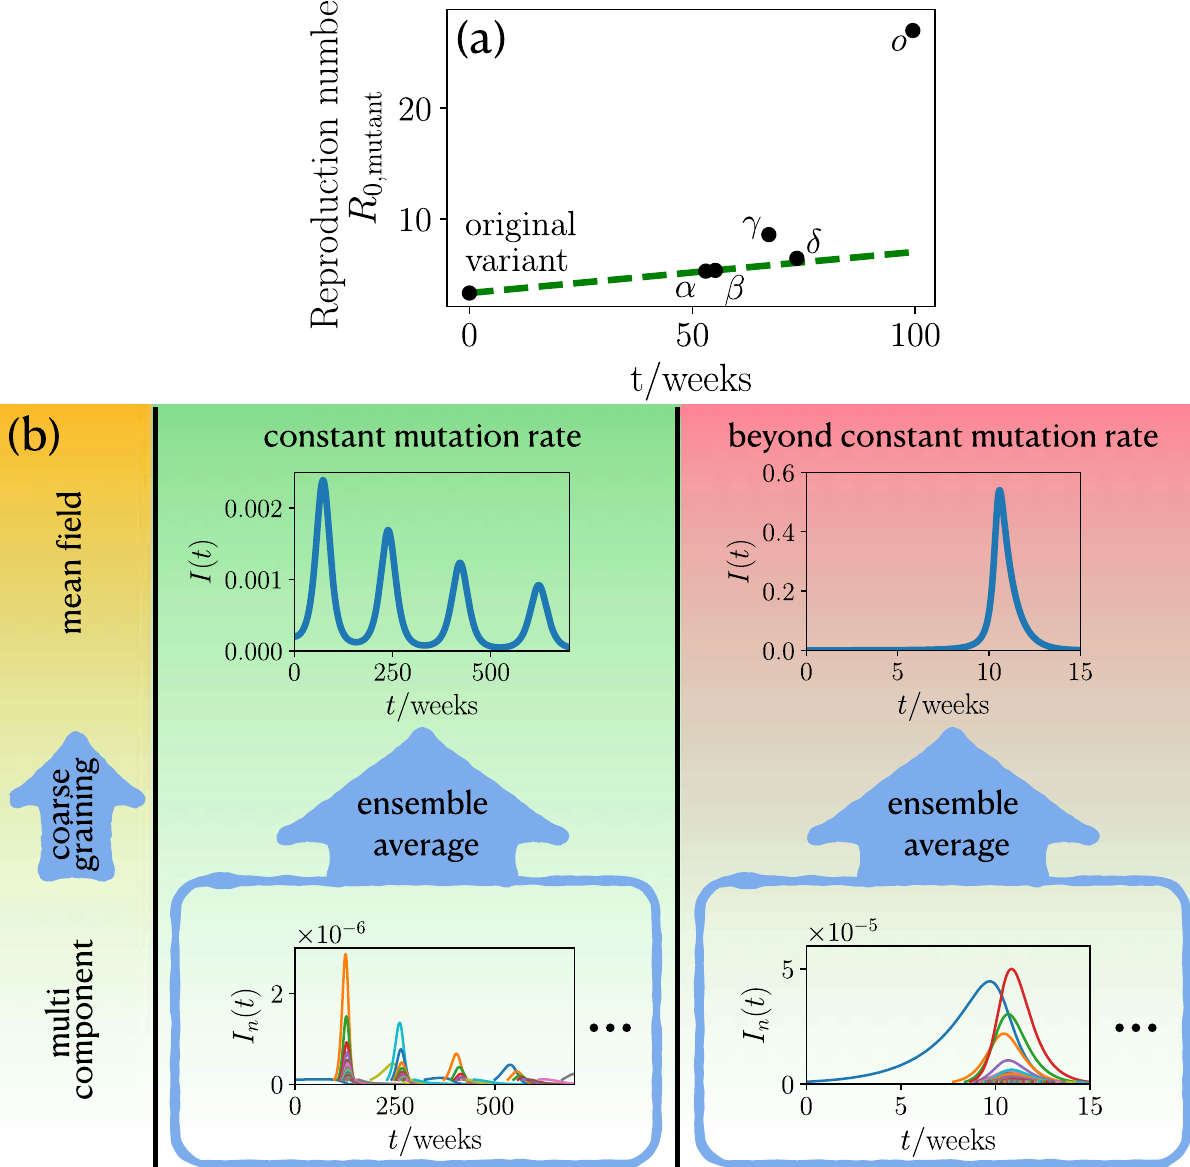
Figure 1. The statistics of mutation formation and its impact on the course of an epidemic. ( a ) Reproduction number for different COVID-19 mutations as a function of the their emergence time (for details see “Methods”). Green dashed line shows a linear fit to initial constant growth. ( b ) For a constant mutation rate (middle panel, green background) an ensemble average of the multi component description with many infection strains I n ( t ) leads to multiple infection waves of the global infection number I ( t ). Beyond the constant mutation rate, if the mutation rate is coupled to the infection number (right panel, red background), the ensemble average produces a hidden singularity, as manifested by the giant infection wave. Only one representative realization of the multi component description is shown in the blue frames. The left panel (yellow background) indicates the different levels of description starting from multi components leading to an effective mean field by coarse